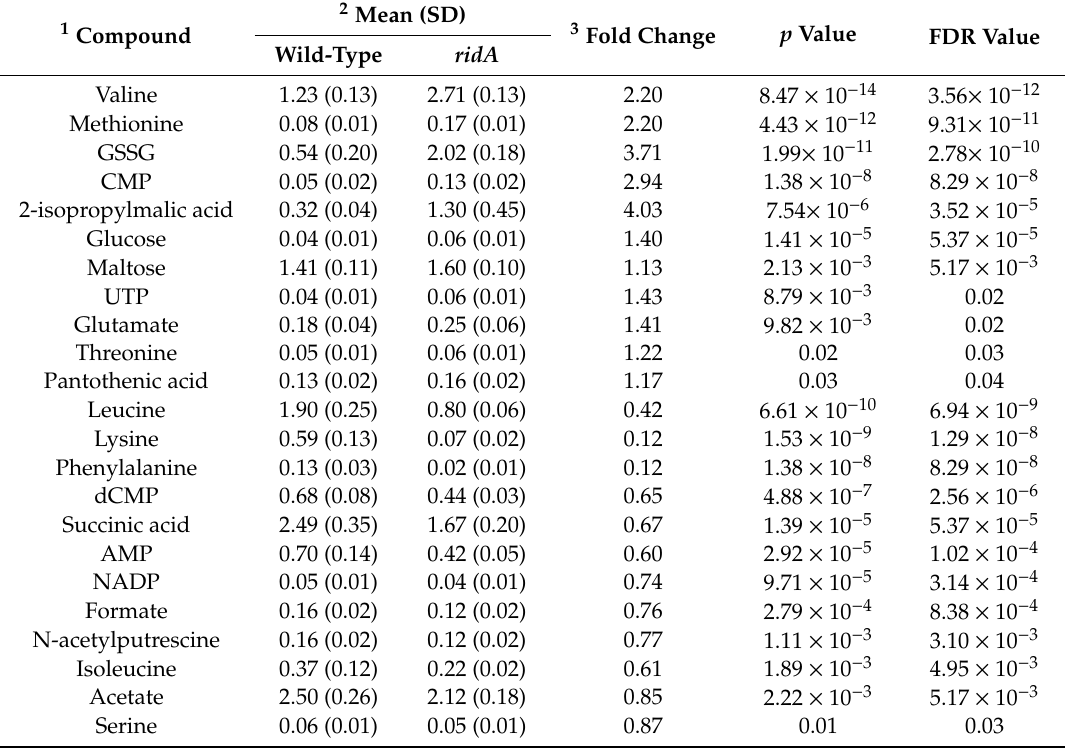
Table 1. Significantly altered (FDR < 0.05) metabolites in S. enterica ridA background.